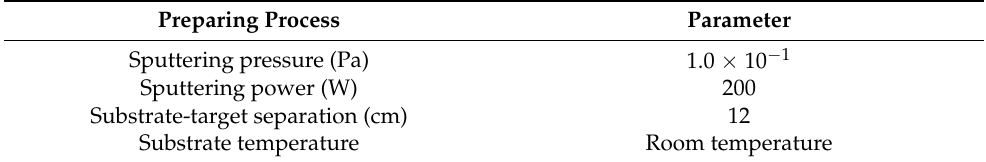
Table 1. Preparing process parameter of F-doped SnO 2 film.